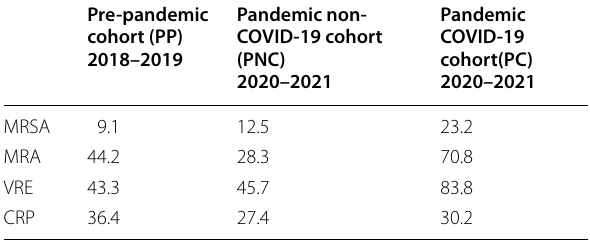
Table 2. Bloodstream infections (/1000 patient